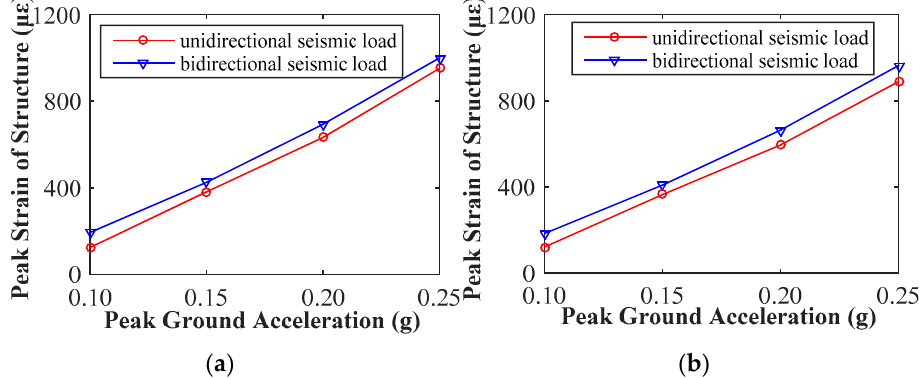
Figure 19. Structural strain response of the electrical platform under a unidirectional and bidirectional seismic wave. ( a ) The strain response of S1 and ( b ) the strain response of S2.